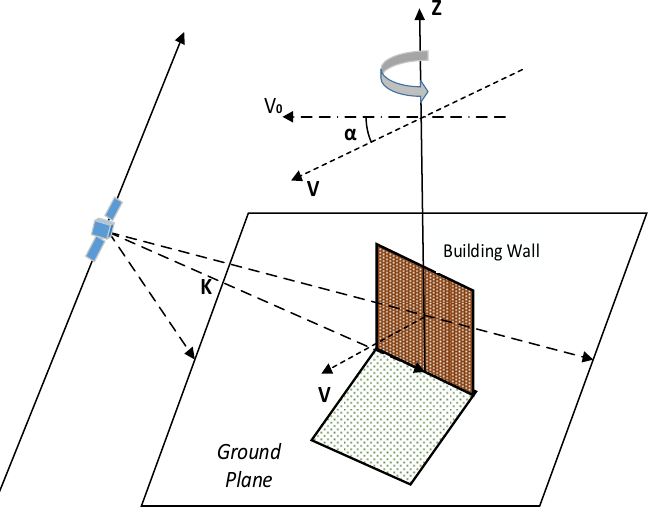
Figure 2. A schematic diagram of a simple geometric model of double-bounce scatters formed between a horizontal ground plane and a rotating building wall.